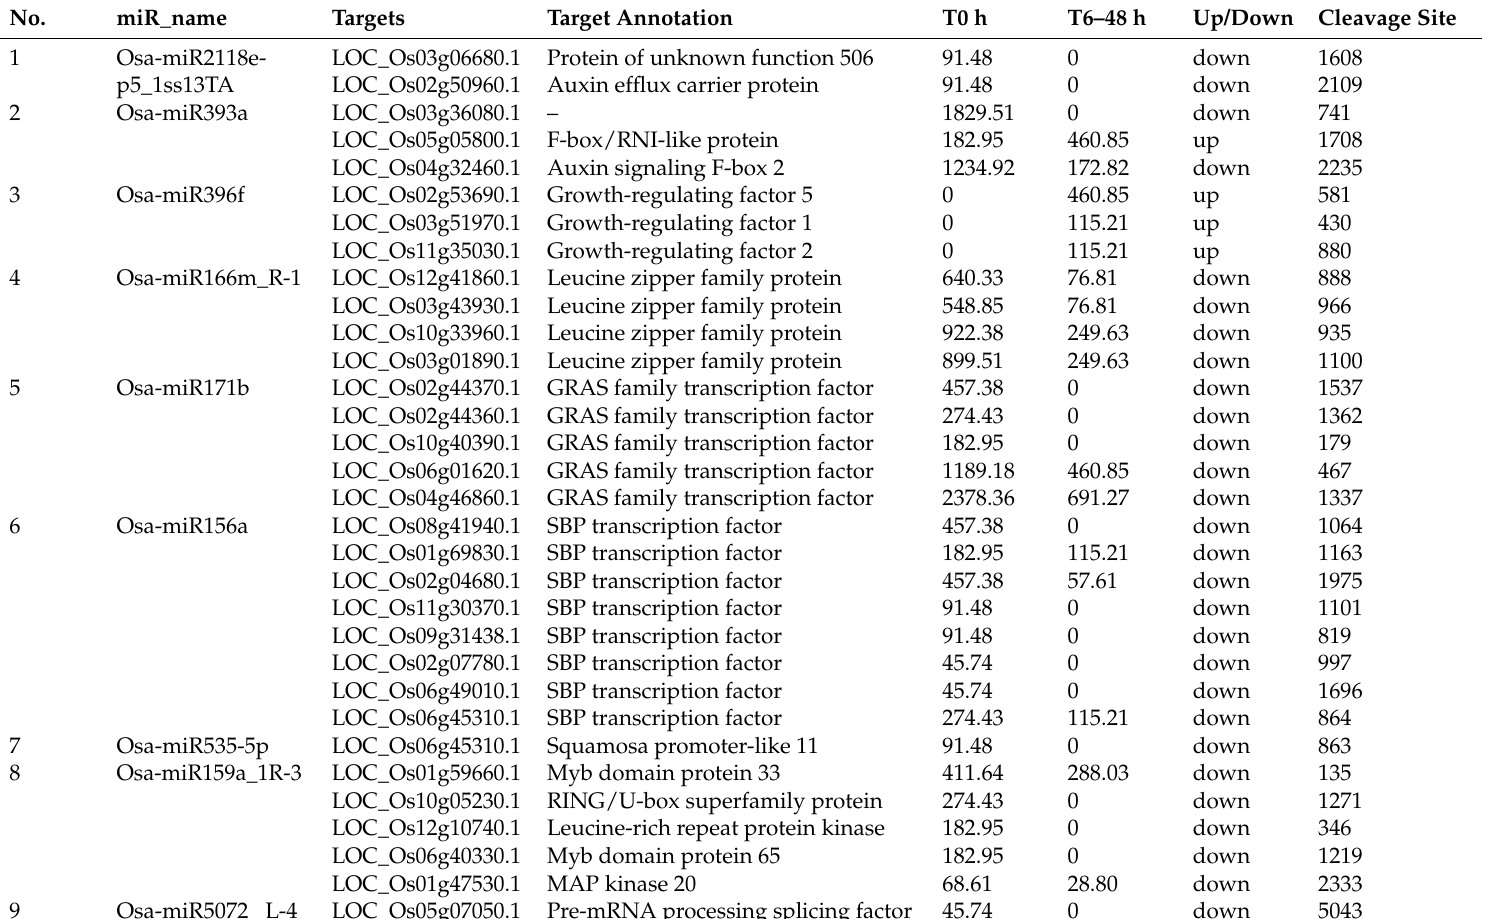
Table 3. The miRNA-target pairs in multi-defense responses detected by miRNA and degradome